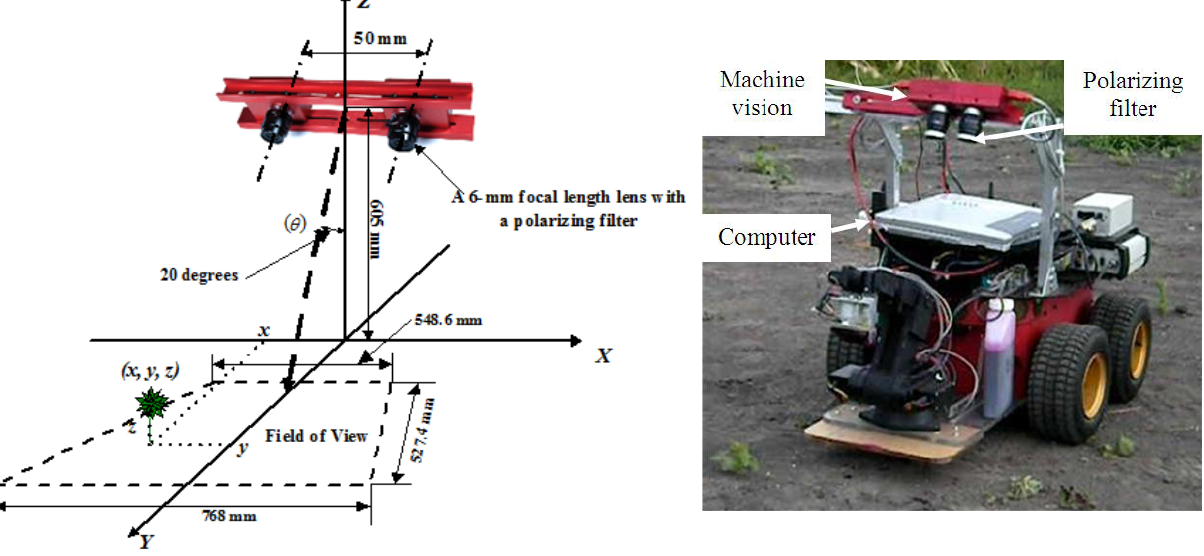
Figure 1. Schematic description of the machine vision installation ( left ) and actual installation of the machine vision on a field robot ( right ). XY plane is the